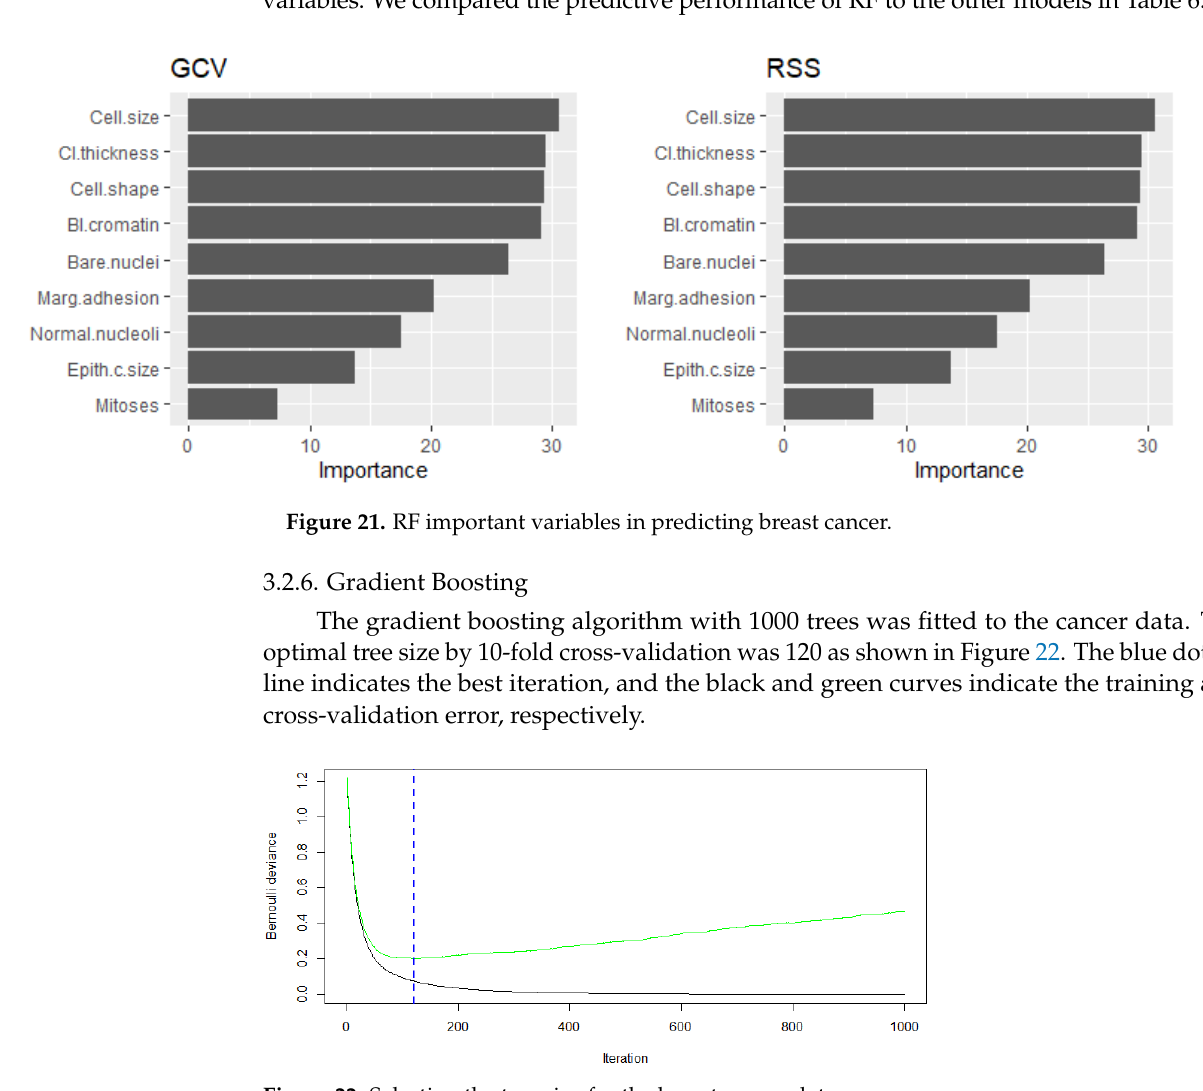
Figure 22. Selecting the tree size for the breast cancer